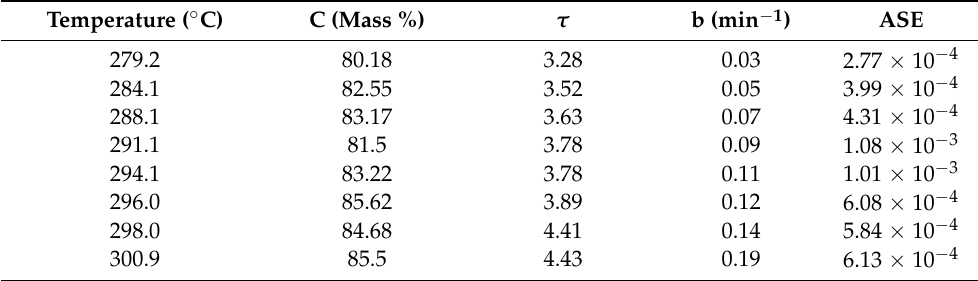
Figure 3. Plots of a DTG curve and its corresponding fittings. Temperature curve is also displayed. The data on the left side of the vertical dashed line were not used for fitting. Table 1. Parameter values resulting from the fittings and the corresponding average squared